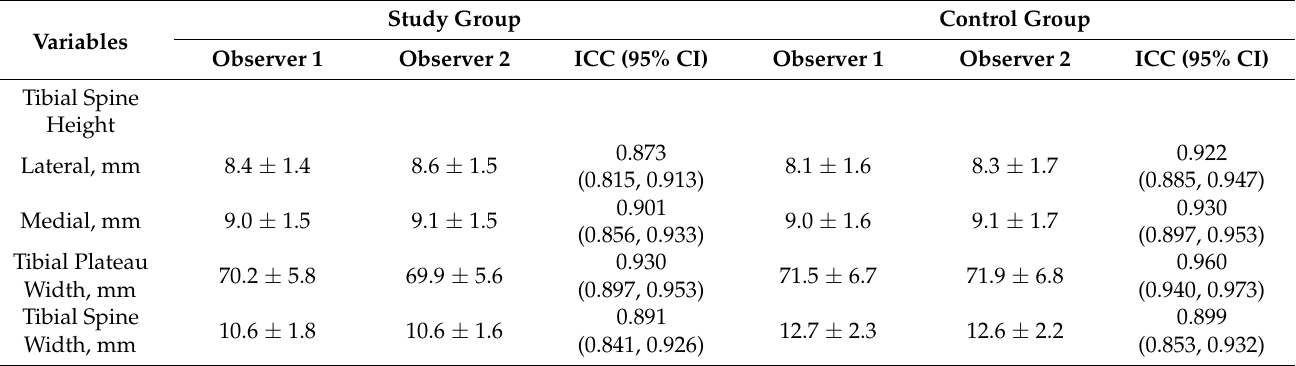
Table 2. Inter-observer reliability analysis and mean ± SD of each anatomic